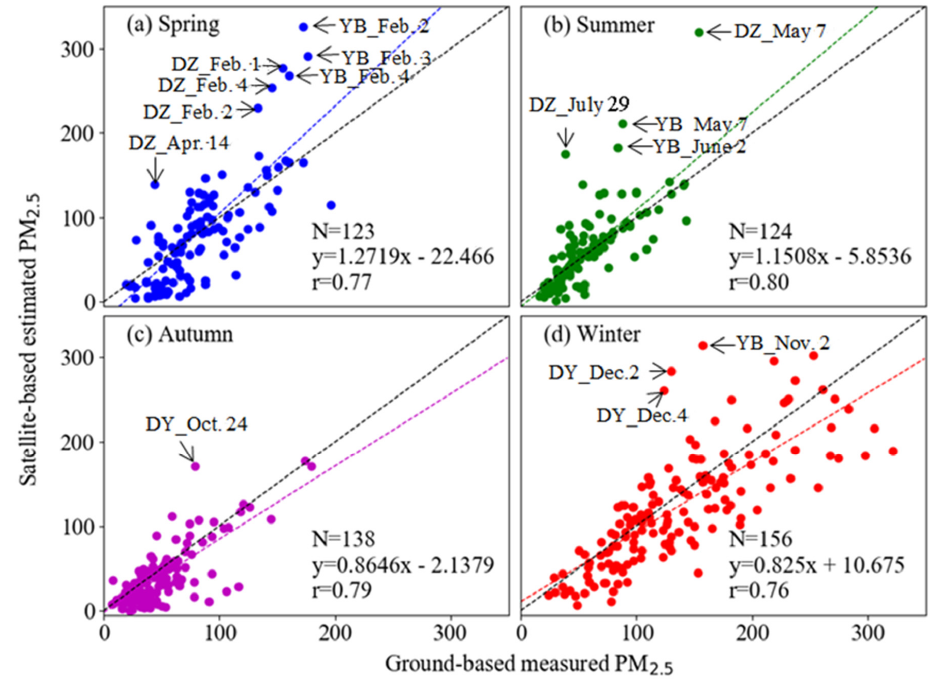
Figure 13. Comparison of daily averaged PM 2.5 retrieved from MODIS and ground-observed (site: YB, DZ and DY) in different seasons.